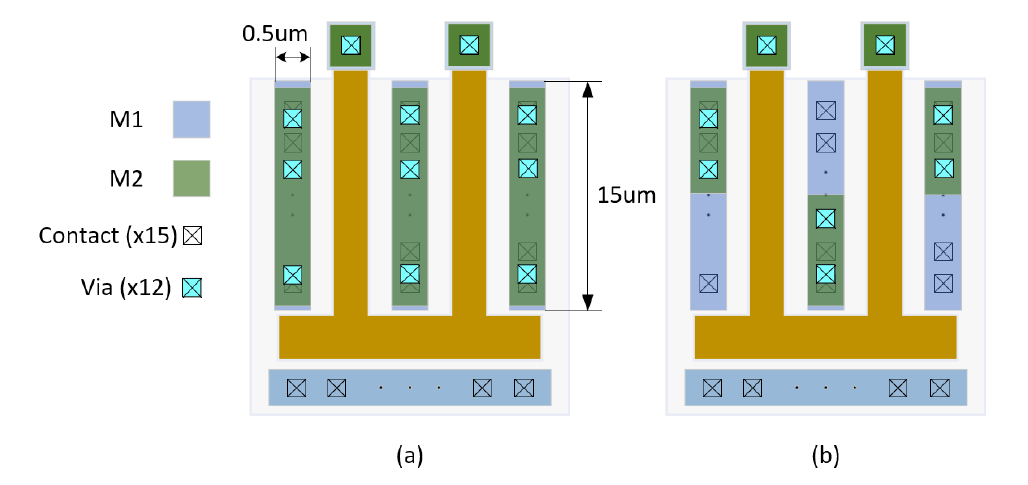
Figure 12. The cross section of FET.